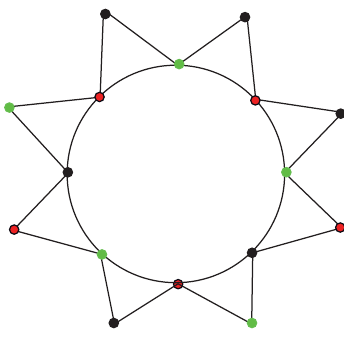
Figure 2: Te graph of M ( C